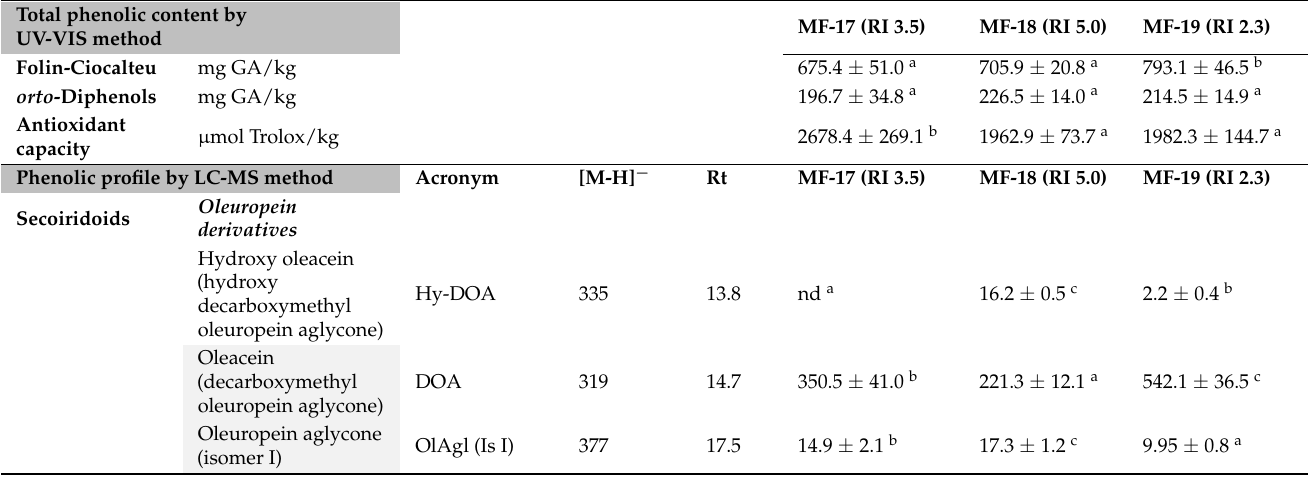
Table 2. Total phenolic content and individual phenolic compounds (mg/kg) determined in ‘Mansa de Figueiredo’ EVOOs throughout different crop